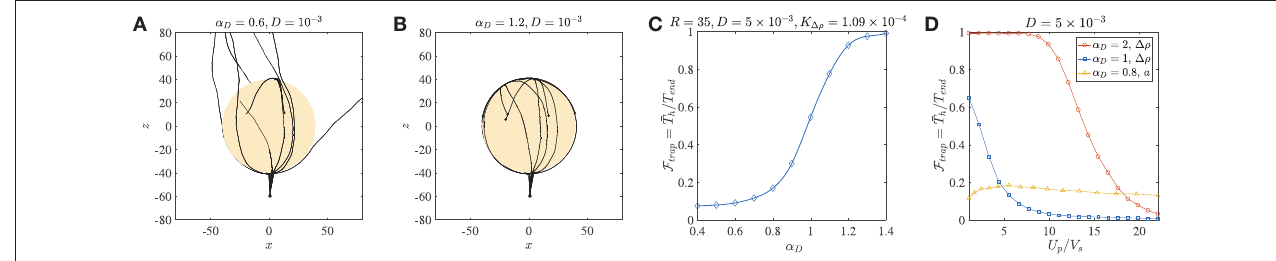
FIGURE 4 | (A) Ten trajectories of bacteria/micro-swimmers (dipole strength α D = 0.6, dimensionless rotary diffusivity D = 10 − 3 ) encountering a sinking sphere of radius R = 40, K 1ρ = 4.36 × 10 − 4 . Note that even though the sphere radius is larger than the corresponding critical trapping radius ( R ct = 28.3), only a few swimmers are trapped if their rotary diffusion is high. The swimmers spend different amounts of time on the sphere surface, before escaping from it. (B) Ten trajectories of micro-swimmers with a higher dipole strength ( α D = 1.2) than case (A) , but same dimensionless rotary diffusivity ( D = 10 − 3 ) encountering the same sinking sphere as in (A) . In this case, all the swimmers stay hydrodynamically trapped upon encountering the sphere, because of their much larger dipole strengths. (C) The trapping fraction F trap as a function of the dipole strength for parameter values given in the title, with T end = 500. Clearly, F trap → 1 if the swimmer’s dipole strength is large enough. (D) The trapping fraction as a function of the aggregate’s settling speed ( U p ) normalized by the bacterium’s swimming speed ( V s ). The legend contains values of the dipole strength, along with the parameter that was varied (to vary U p ) in each case. In the plots marked by circles and squares, T end = 500; U p is changed by changing the excess density ( 1ρ ) of the aggregate from 10 − 4 g/cm 3 to 2 × 10 − 3 g/cm 3 , and aggregate radius is fixed at a = 45 µ m. In the plots marked by triangles, T